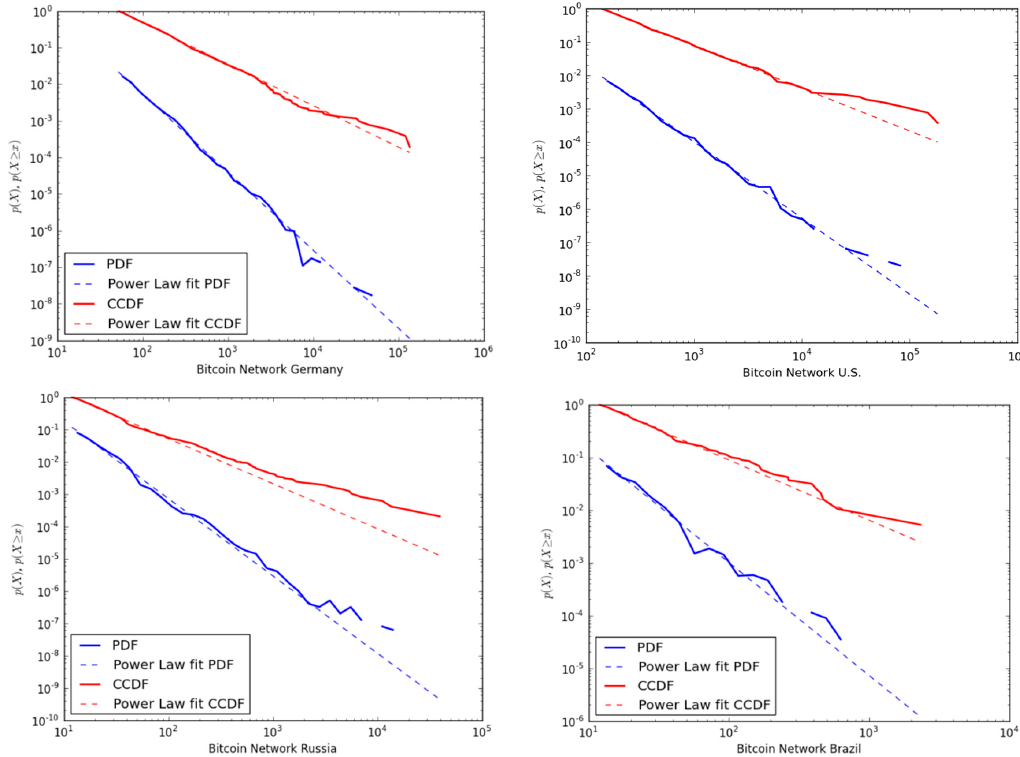
Figure 25. Degree Distribution (PDF, CCDF) for different Countries.